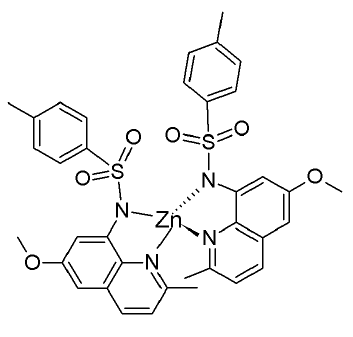
Figure 4. The Zn 2+ complex of 2-Me-TSQ.